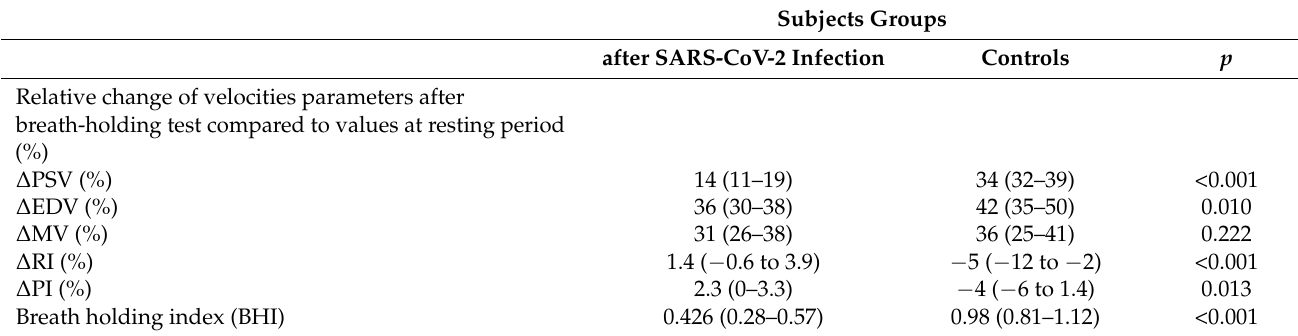
Table 5. Median (Q1–Q3) presentation of changes in flow velocities rates through middle cerebral artery after breath-holding test and rest period in relation to groups of